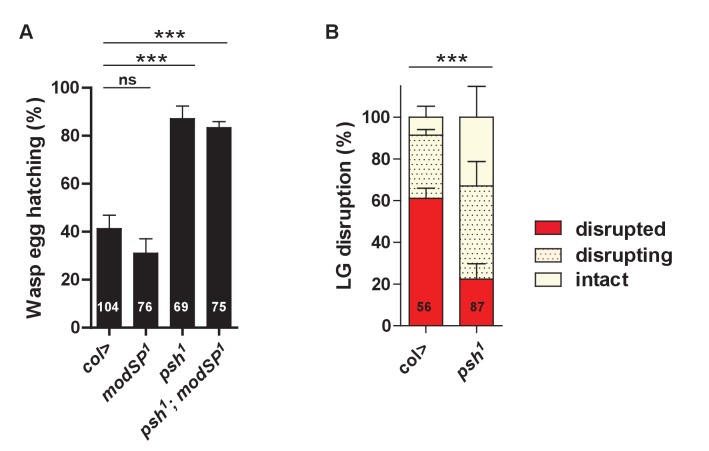
Psh is required for wasp egg neutralization and timely lymph gland disruption.(A) Quantification (%) of wasp egg hatching in control (col>), modSP1, psh1 and double psh1; modSP1 mutants. (B) Quantification (%) of lymph gland disruption in control (col>) and psh1 mutants. Error bars correspond to SEM, ***p<0.001, ns (not significant) (Pearson’s Chi-squared test).10.7554/eLife.25496.026Figure 5—figure supplement 1—source data 1.Wasp egg hatching quantification.10.7554/eLife.25496.027Figure 5—figure supplement 1—source data 2.Lymph gland disruption quantification.